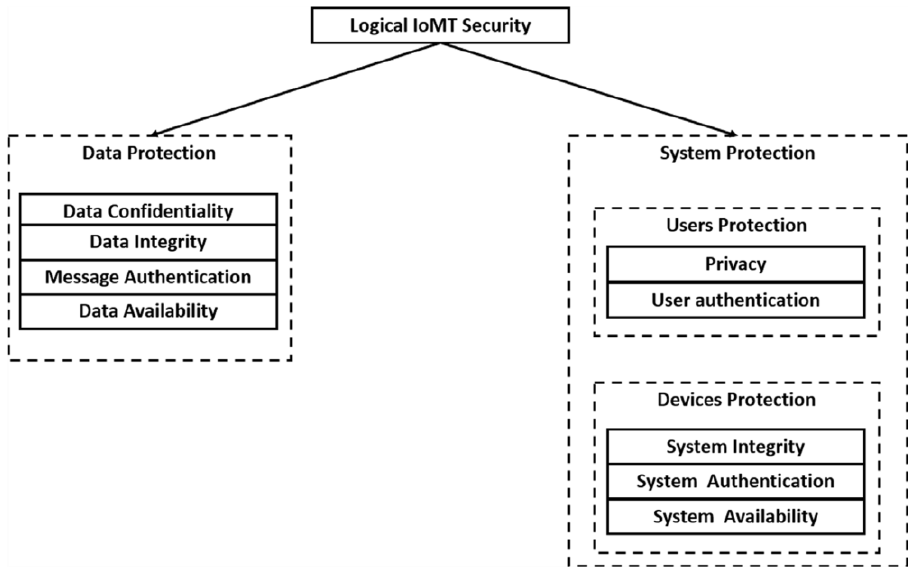
Figure 35. IoMT security goals [114]. Abbreviations used: IoMT, Internet of Medical Things. Reprinted with permission from ref. [114]. 2020 Elsevier.